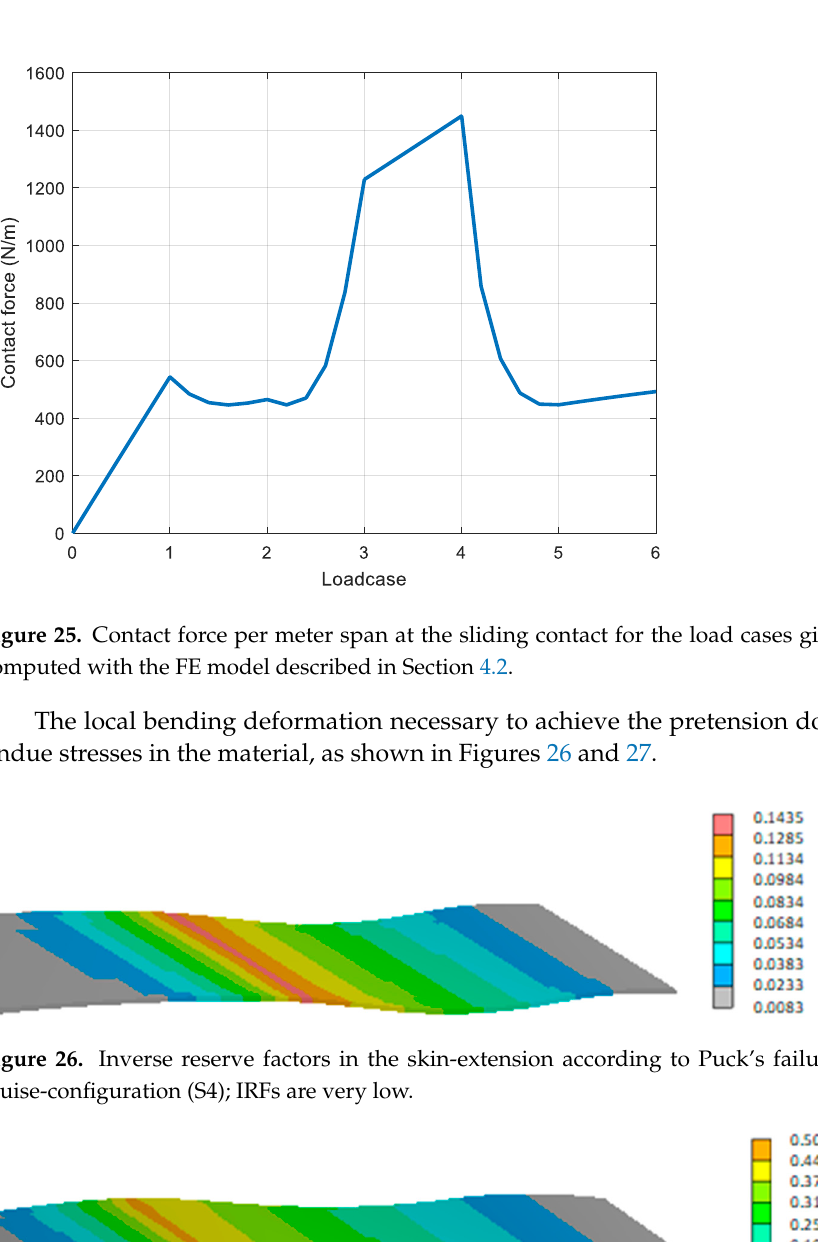
Figure 26. Inverse reserve factors in the skin- extension according to Puck’s failure criterion in cruise-configuration (S4); IRFs are very low. Figure 27. Inverse reserve factors in the skin-extension according to Puck’s failure criterion in high-lift configuration (S5); IRFs are higher than in cruise-configuration but still acceptable.